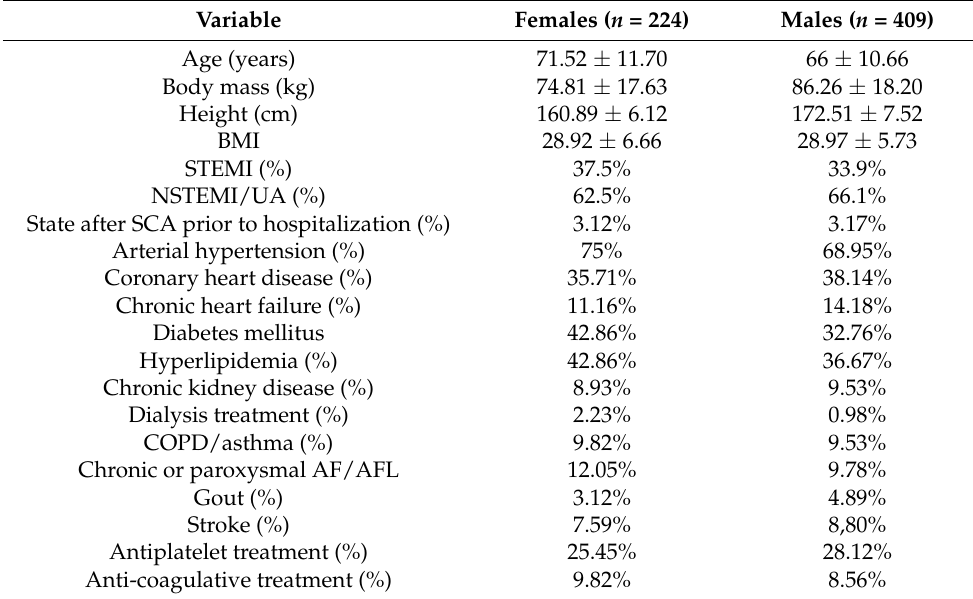
Table 2. Baseline characteristics of study